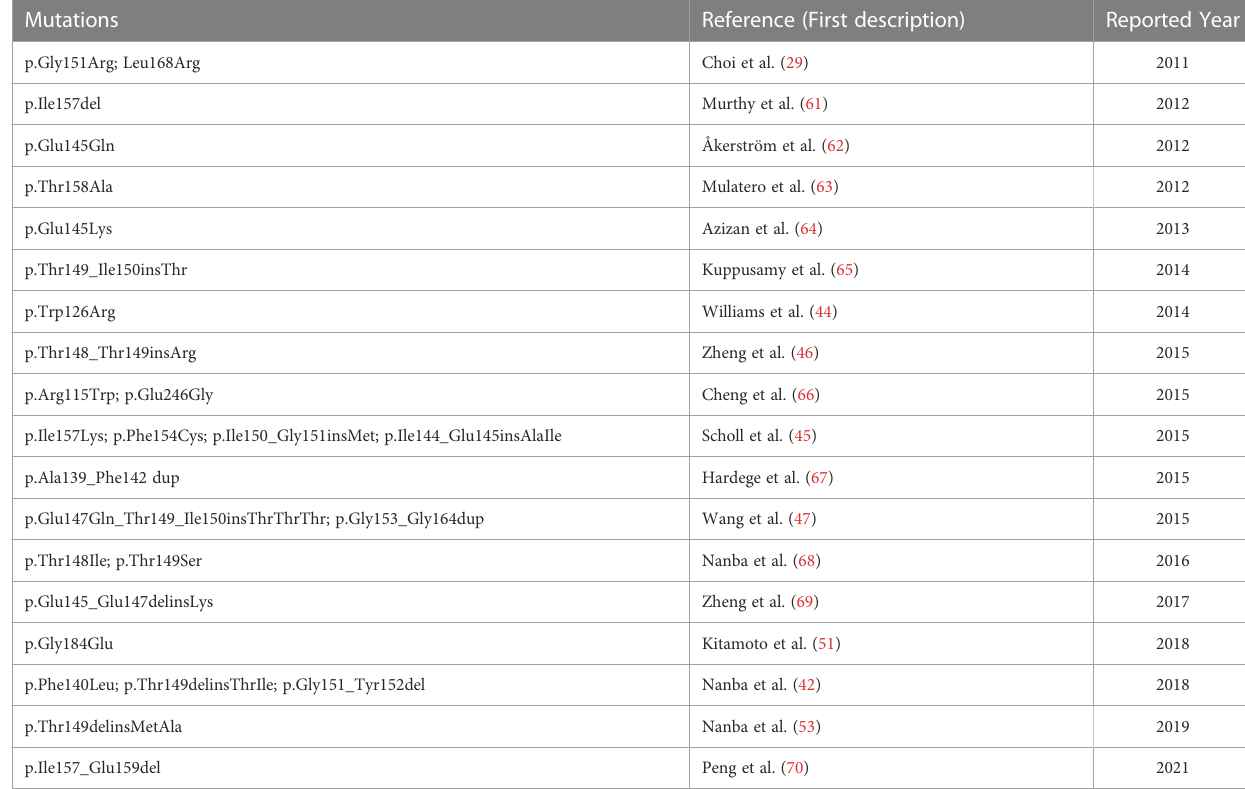
TABLE 2 KCNJ5 somatic mutations identi fi ed in